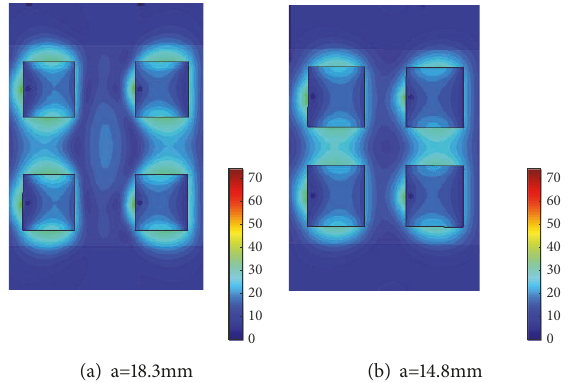
Figure 8: Surface current of the generator with different radiuses (unit: A/m(log)).